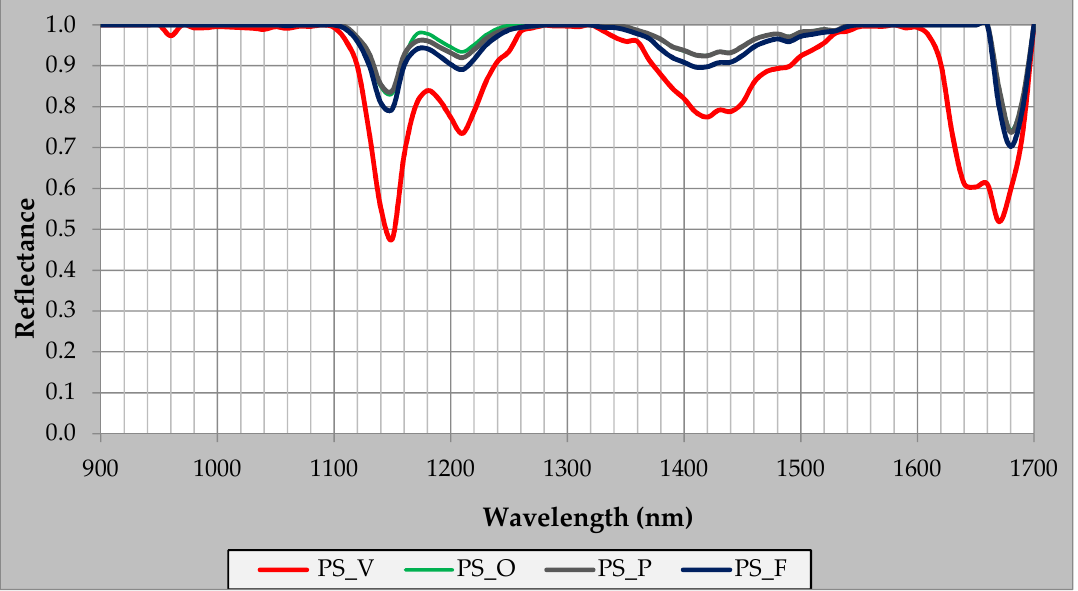
Figure 6. Spectral signatures of PS samples in the NIR region, detected with linear spectrometer, processed with the method Continuum Removal (CR).